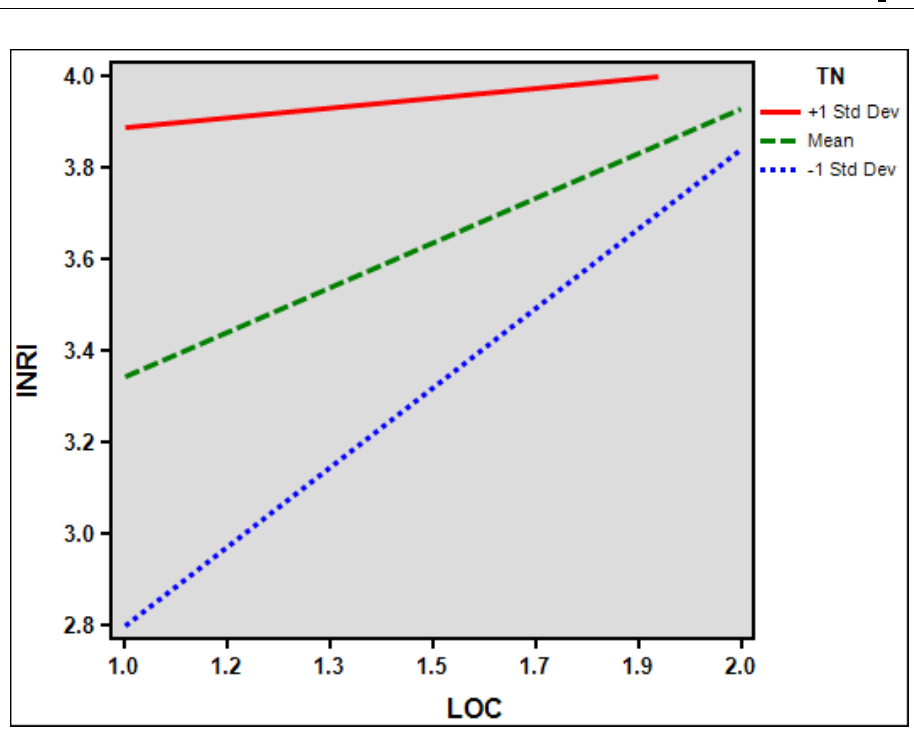
Figure 3. The plot of the interaction effect of team norms on the relationship between locus of control and auditor reporting